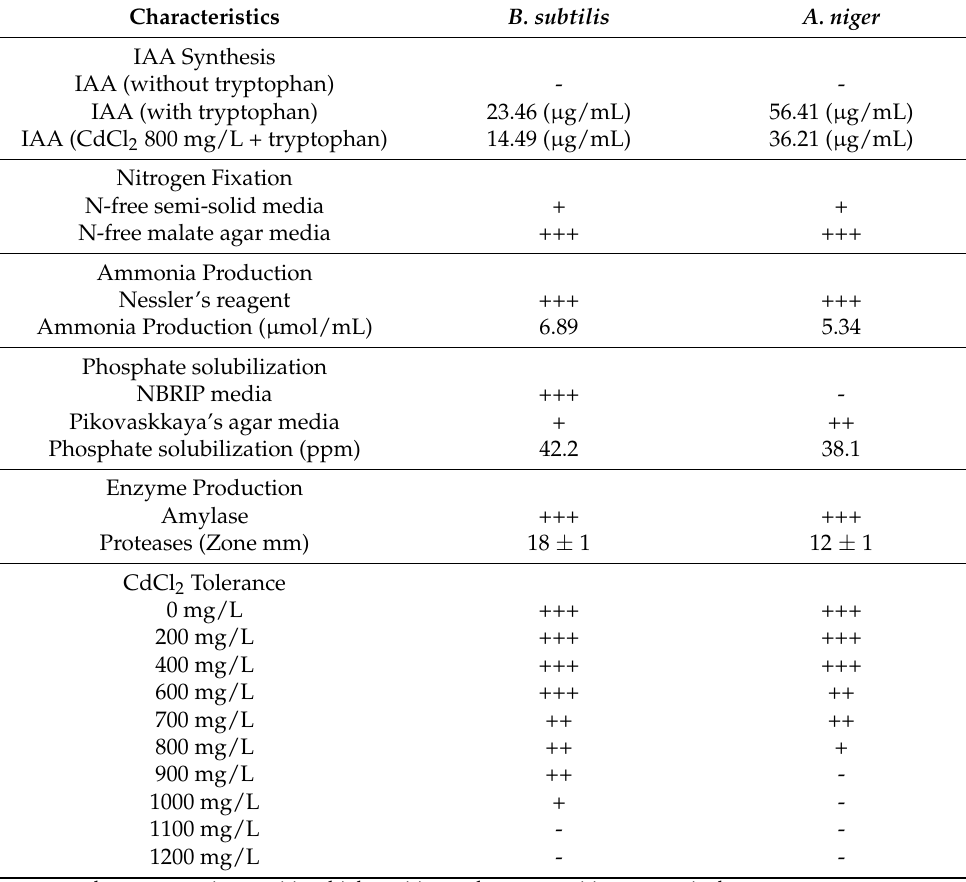
Table 2. Characterization of the microbes for the metal tolerance, enzyme production and PGP traits.